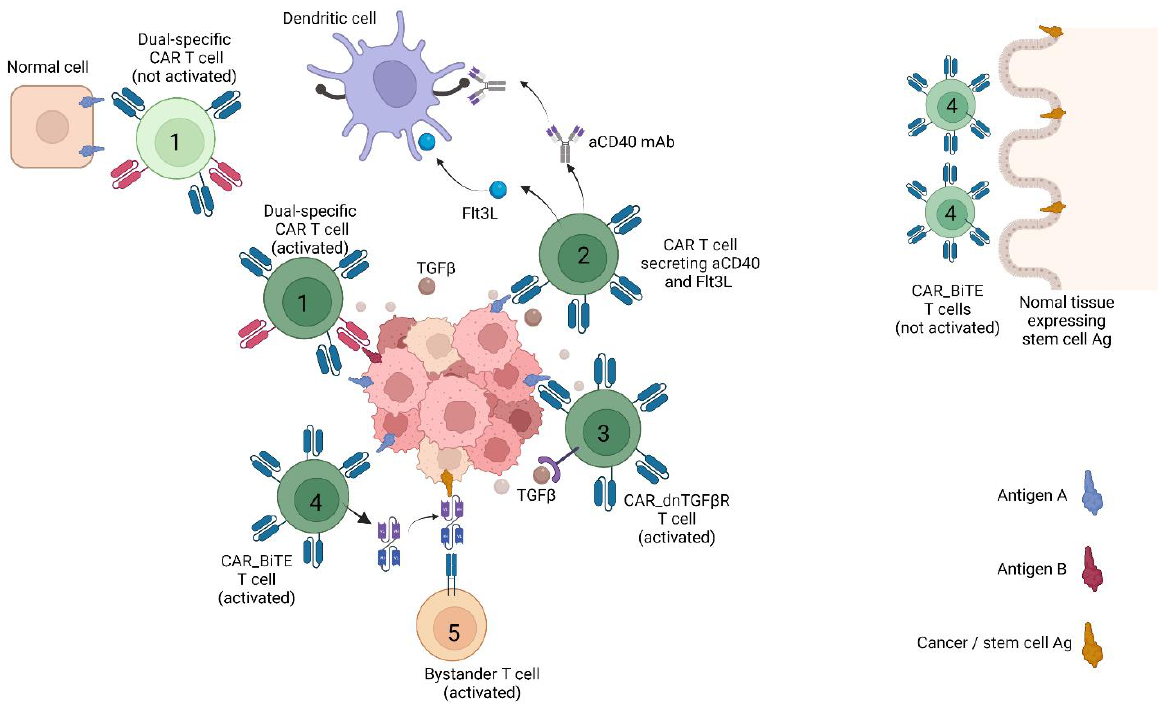
Figure 1. CAR T strategies countering heterogeneity and immune suppression in solid tumours. The figure depicts CAR T strategies that have been reported to work in animal models. T cells are labelled as follows: ( 1 ) Dual-receptor CAR T cells only activated in the presence of antigen A and B. ( 2 ) CAR T cell secreting the growth factor Flt3L or an agonist mAb against CD40, both of which stimulates dendritic cells. ( 3 ) CAR T cell resistant to TGF β suppression due to double negative, non-signalling TGF β receptor (dnTGF β -R) . ( 4 ) T cell that upon CAR activation secretes a bispecific T cell engager (BiTE) against a cancer stem cell Ag also expressed by normal stem cell. ( 5 ) Bystander T cell with irrelevant specificity triggered by BiTE against cancer stem cell Ag. Created with BioRender.com. In addition, normal tissue expressing stem cell Ag was not discussed in main texts.